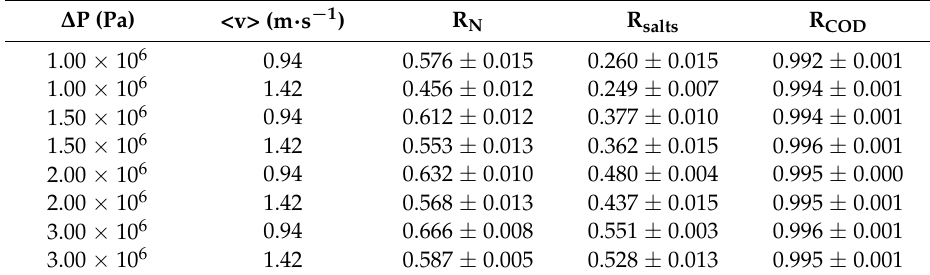
Table 4. Apparent rejection coefficients to nitrogen N (kjeldahl), salts, and chemical oxygen demand (COD) obtained during nanofiltration of PUF-S, at different transmembrane pressures, feed circulation velocities, and a temperature of 25 ◦ C. ∆ P (Pa) <v> (m · s − 1 ) R N R